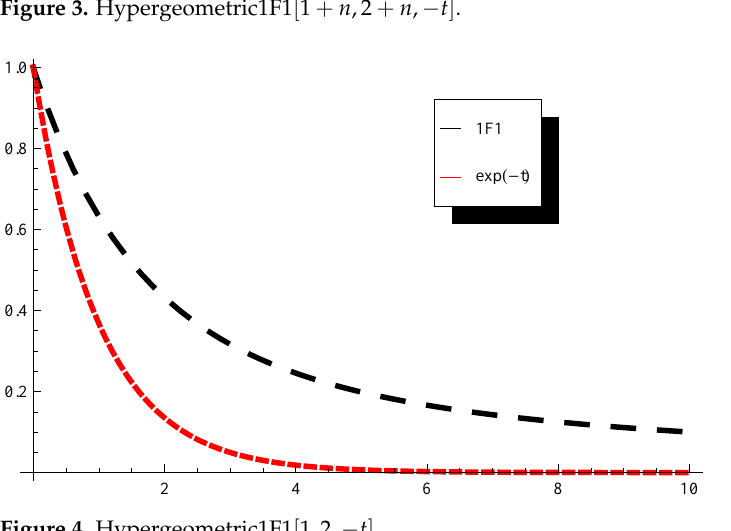
Figure 4. Hypergeometric1F1 [ 1,2, − t ] . The time evolution of the approximate solution of the classical Equation (5), i.e., as γ = 2, α = 1, β = 2, a ( x ) = 1, b ( x ) = − x and f ( x ) = sin π x